Question: Name the type of graph shown.
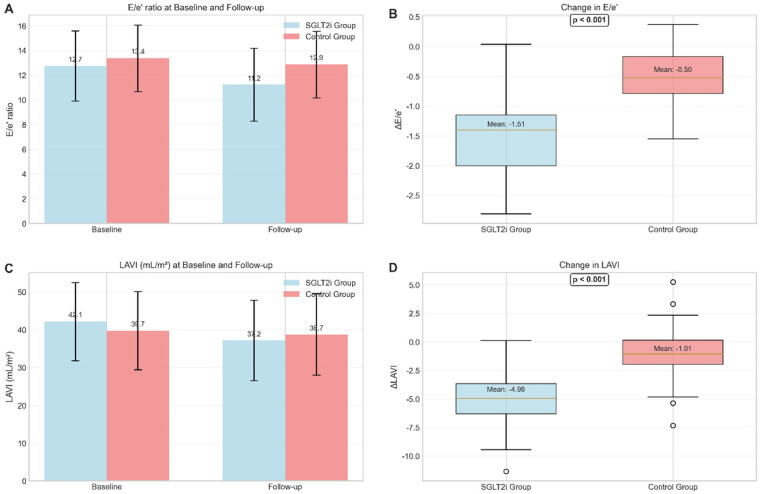
Answer: bar